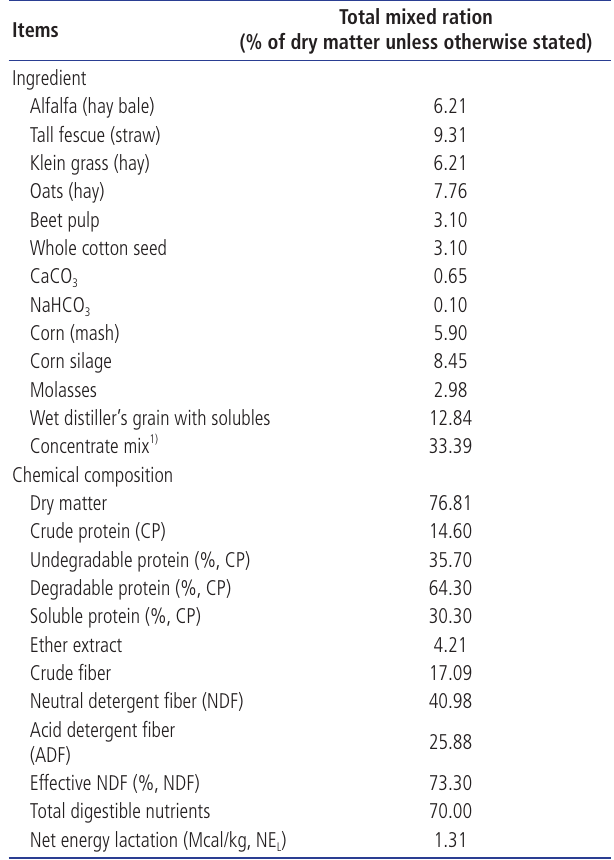
experiment 1 (in vitro) and in experiment 2 (in